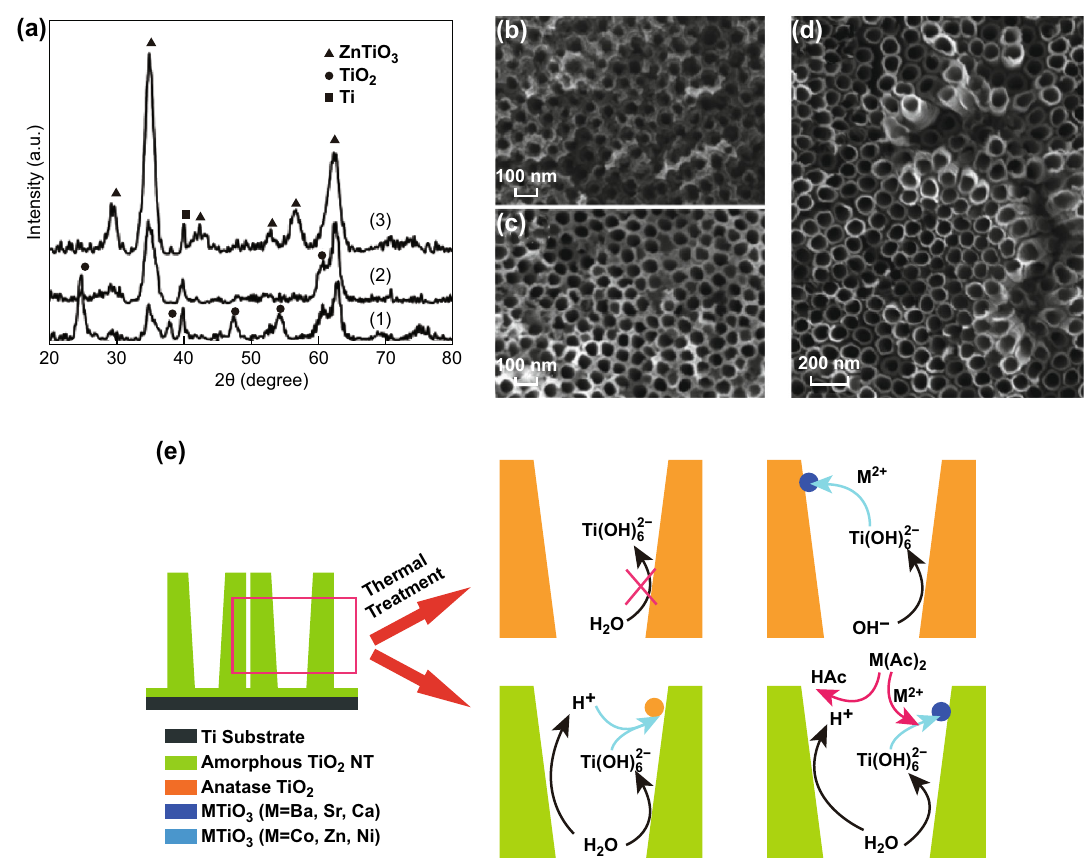
Fig. 6 a XRD patterns of the as-hydrothermal samples after annealing at 450 (cid:3) C for 3 h in air (lines 1, 2, 3 represent the 0.05 M, 0.2 M, and 0.5 M Zn (Ac) 2 solutions). SEM images of the samples hydrothermally treated with Zn(Ac) 2 solutions with different concentrations at 200 (cid:3) C for 6 h: b 0.05 M and c 0.5 M. d SEM image of anatase TNTs after hydrothermal treatment in 0.2 M Zn (Ac) 2 at 200 (cid:3) C for 6 h [67]. e Schematic illustration of the reaction processes in the presence of anatase or amorphous TNTs. Copyright (cid:2) 2014 The Royal Society of